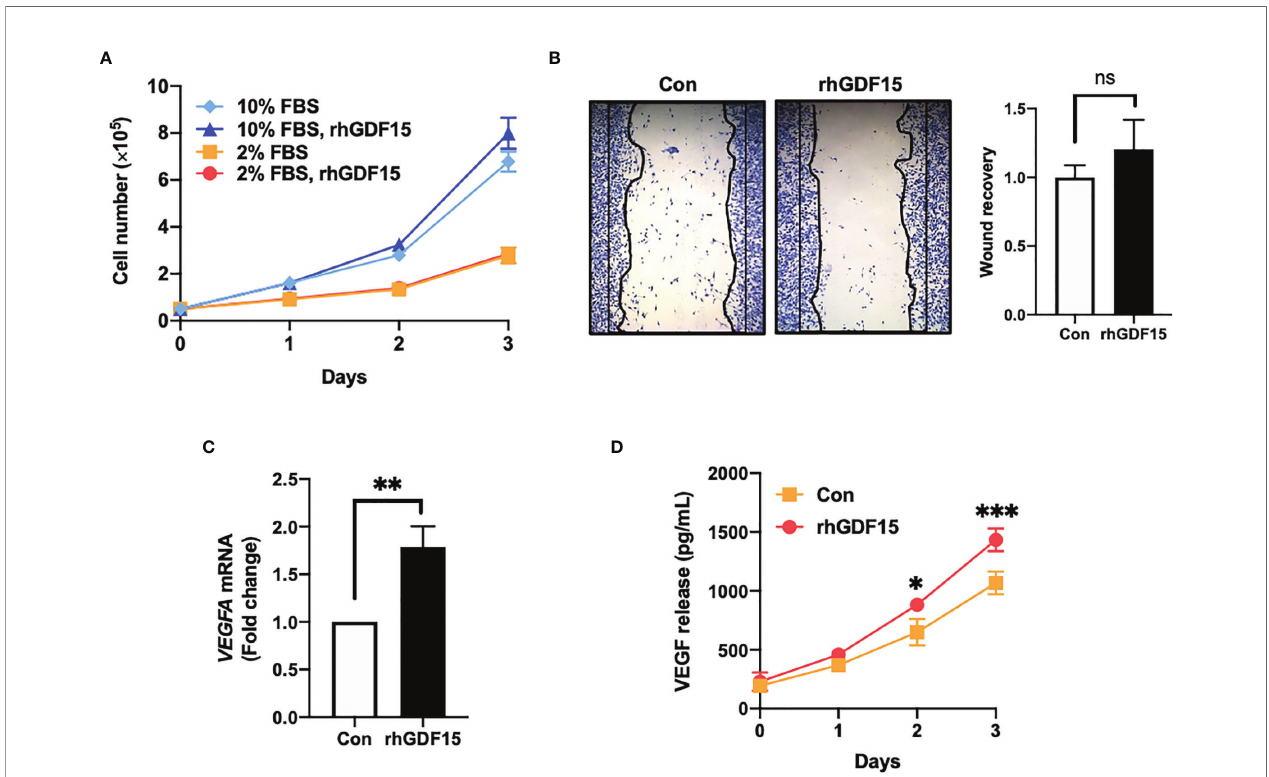
FIGURE 2 | GDF15 promotes VEGFA expression in U373 glioblastoma cells but not proliferation and migration of U373 cells. (A) U373 cells were treated with 100 ng/mL rhGDF15 protein for 3 days in a medium with different serum concentrations (2% or 10% fetal bovine serum) and the cells were counted daily. (B) The cells were seeded on 12-well plates (3 × 10 5 cells/well) and cultured for 1 day. The monolayer was scratched and incubated for 24 h in a medium containing 2% serum. Subsequently, the cells were stained with a fi xation solution containing trypan blue. (C) The VEGFA mRNA levels in rhGDF15-stimulated U373 cells were measured using quantitative reverse transcription polymerase chain reaction. (D) Soluble VEGF was quanti fi ed in the enriched culture medium containing 2% serum using enzyme-linked immunosorbent assay from days 1 – 3. Data are presented as the mean ± standard deviation of three experiments. * p < 0.05, ** p < 0.01, and *** p < 0.001 compared with control group. ns, no signi fi